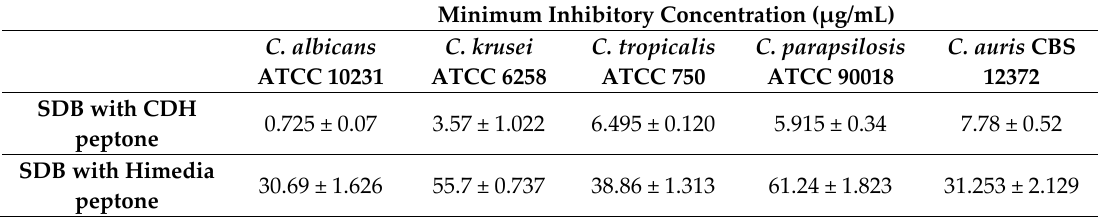
Table 1. MIC 90 values of ADP4 metabolite extract against Candida pathogens.